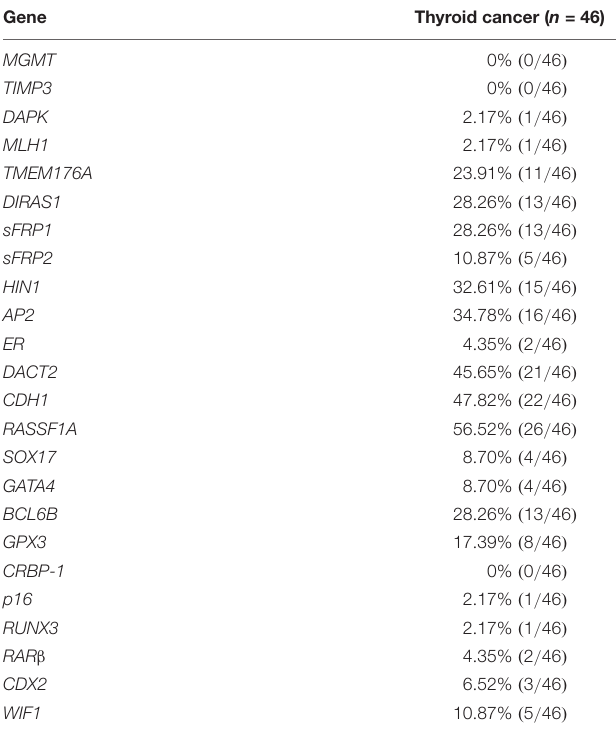
TABLE 1 | Methylation status of 24 genes in discovery